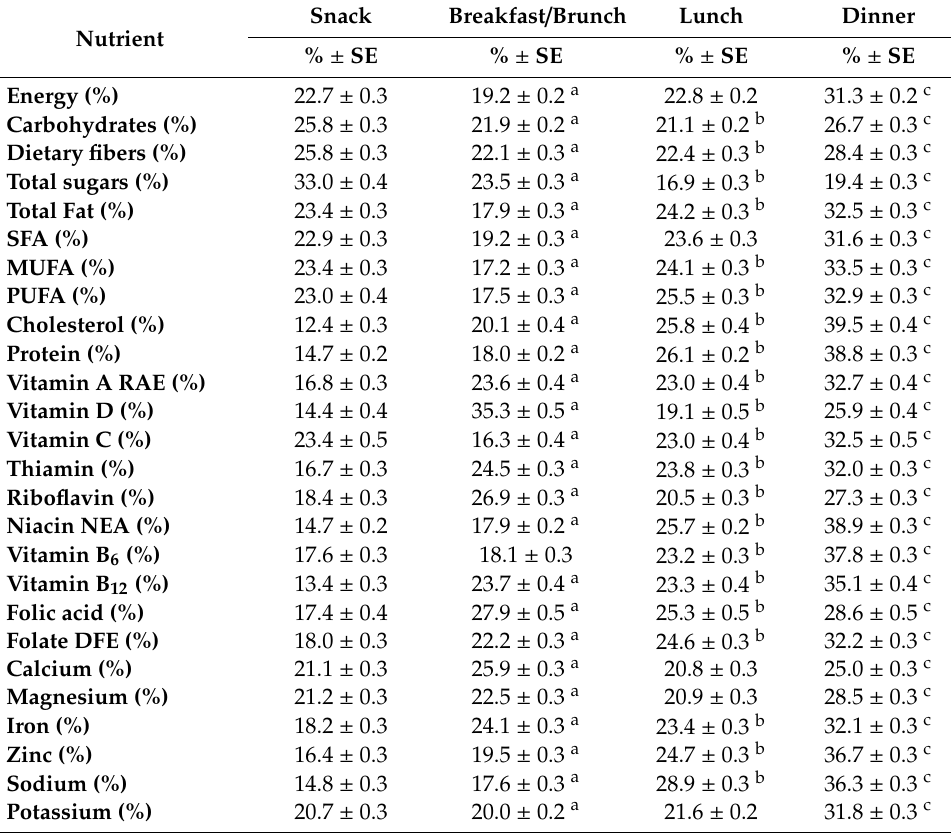
Table 2. Percent contribution of nutrients from food occasions to daily intake among snack consumers ( n = 26,896,800) 1